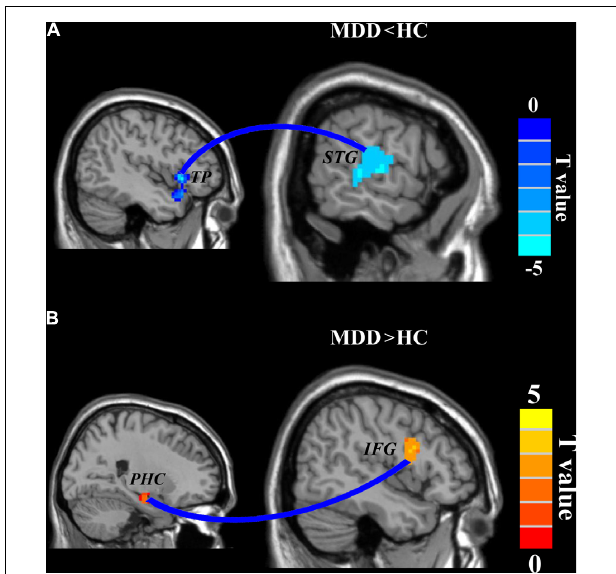
FIGURE 3 | Disrupted functional connectivities in major depressive disorder (MDD) patients. Two-sample t -tests were used to identify the significant differences in functional connectivity between MDD and healthy control groups. (A) Significantly decreased functional connectivity between left temporal pole and right superior temporal gyrus and (B) significantly increased functional connectivity between right parahippocampus and right inferior frontal gyrus were found. The significance was determined using a cluster-level Monte Carlo simulation (5000 times) corrected threshold of p < 0.05 (cluster-forming threshold at voxel-level p <